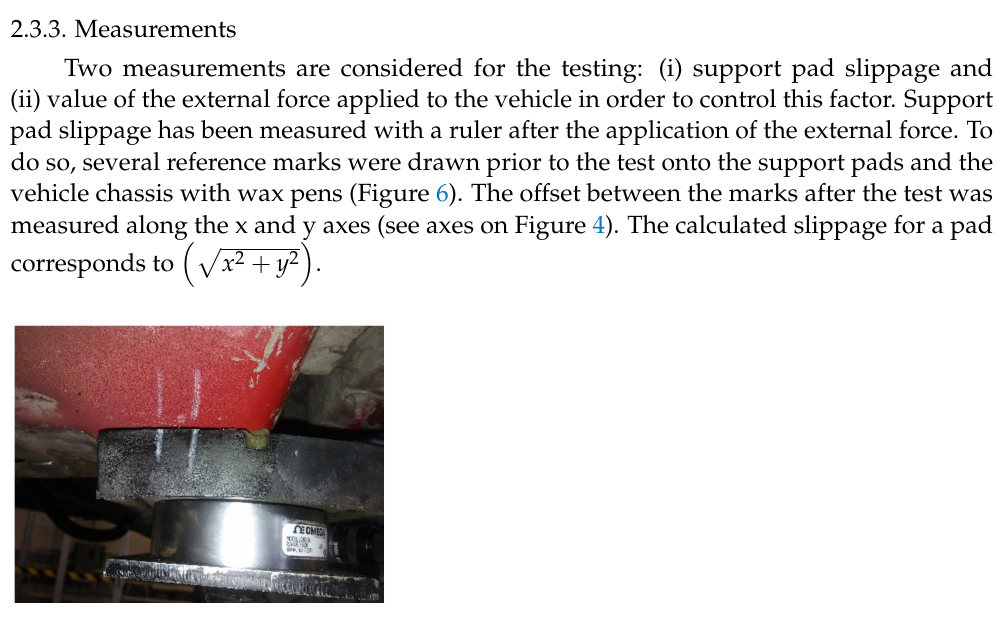
Figure 5. ( a ) Load cell assembly for lateral force applied to the rear wheel. ( b ) Load cell assembly for vertical force applied to the trunk.